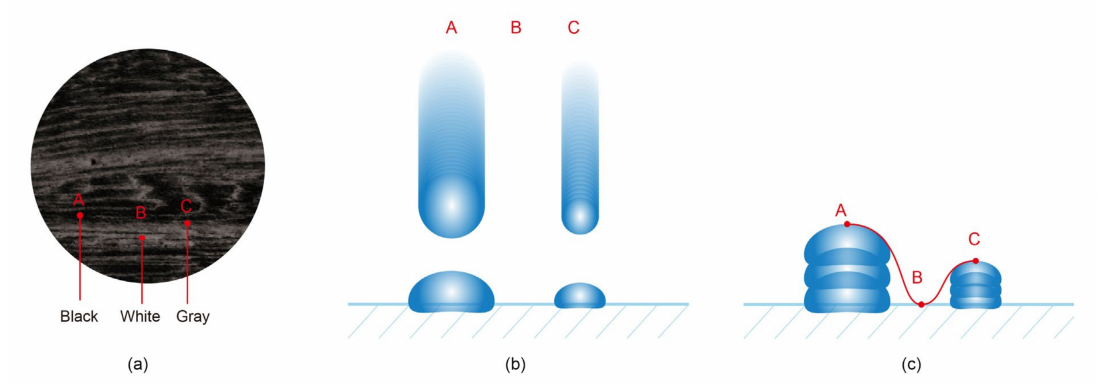
Figure 6. ( a ) Black, white, and gray dots in the grayscale image, ( b ) ink droplet curing on substrate, and ( c ) 3D texture formation by UV-curable ink